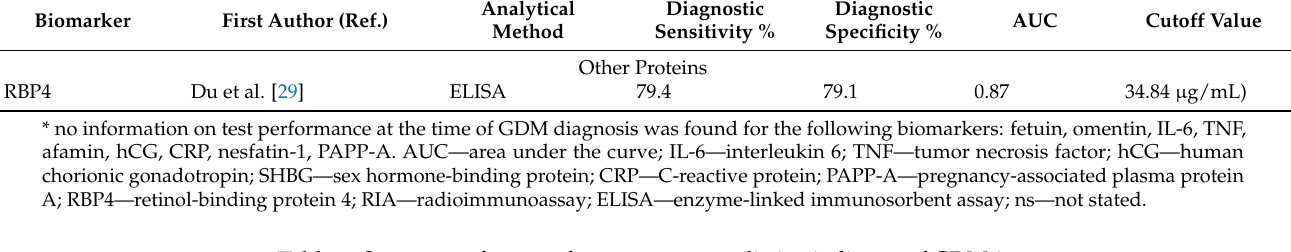
Table 3. Summary of test performance as a predictive indicator of GDM